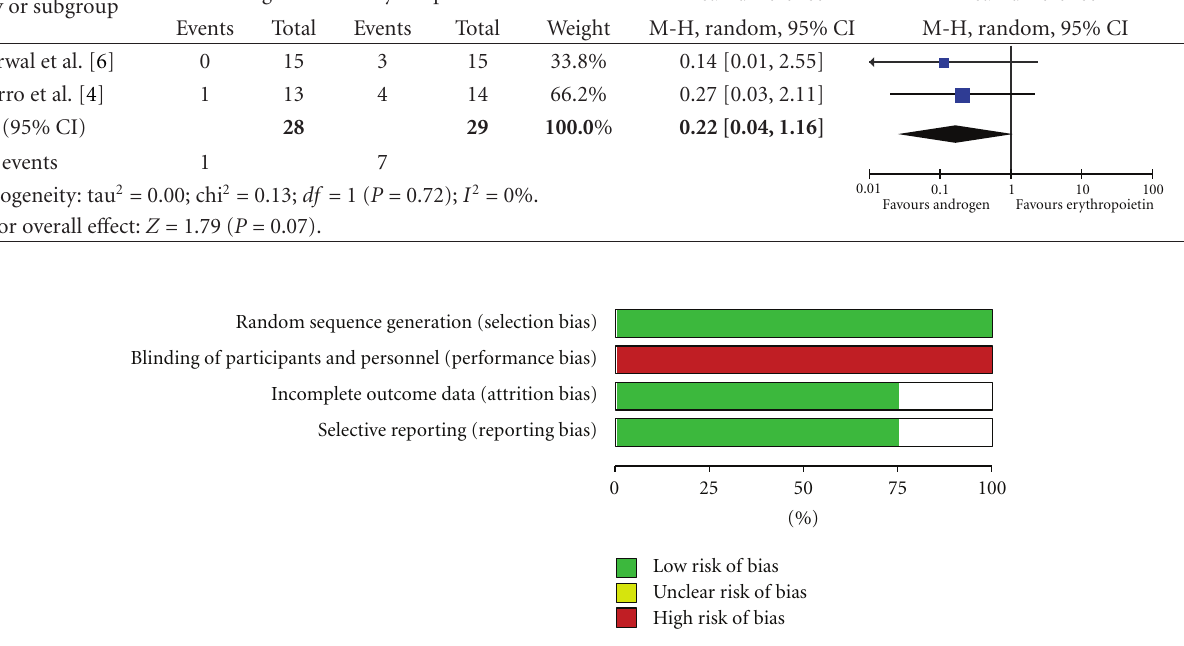
Figure 2: Representing Authors’ methodological assessment of risk of bias across the